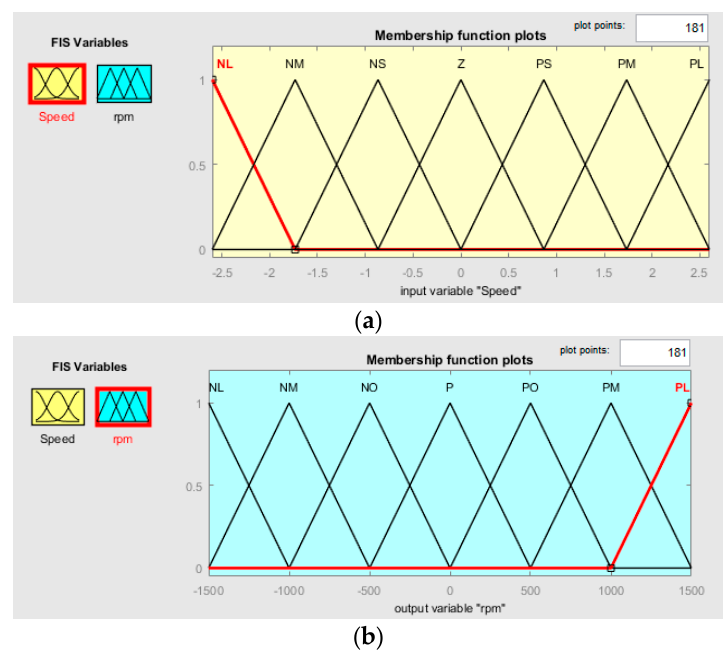
Figure 6. ( a ) Input variable—membership of the estimated speed of AUV to reach the target object; ( b ) output variable—membership of the propeller revolution speed.